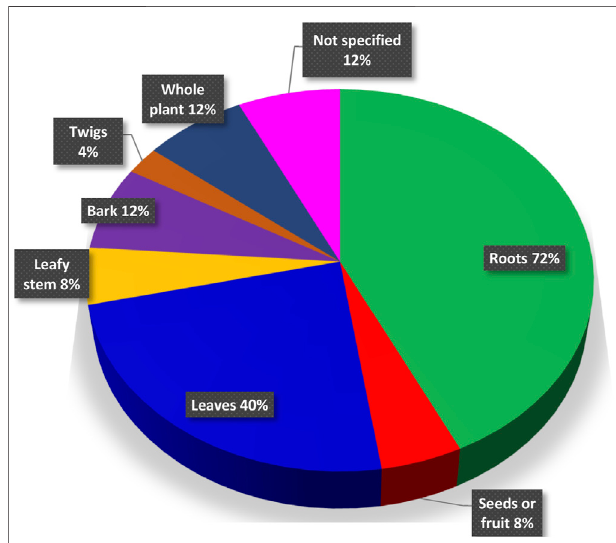
FIGURE 1 | Traditionally used plant parts of Eriosema